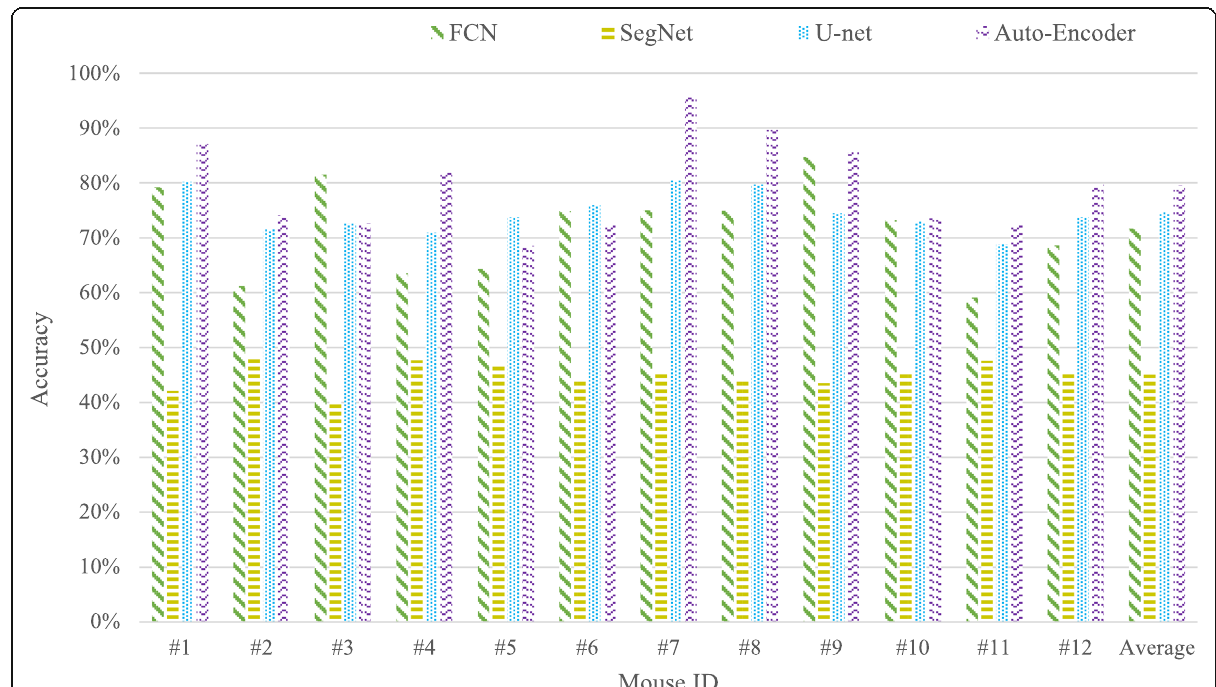
Fig. 7 The accuracy of cancer detection for each mouse and their average one for the method FCN, SegNet, U-net, and auto-encoder used in this